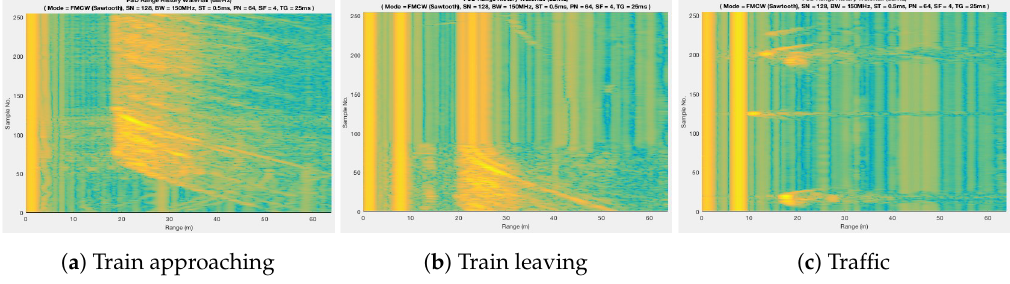
Figure 15. Phase 2 field test test case returns.